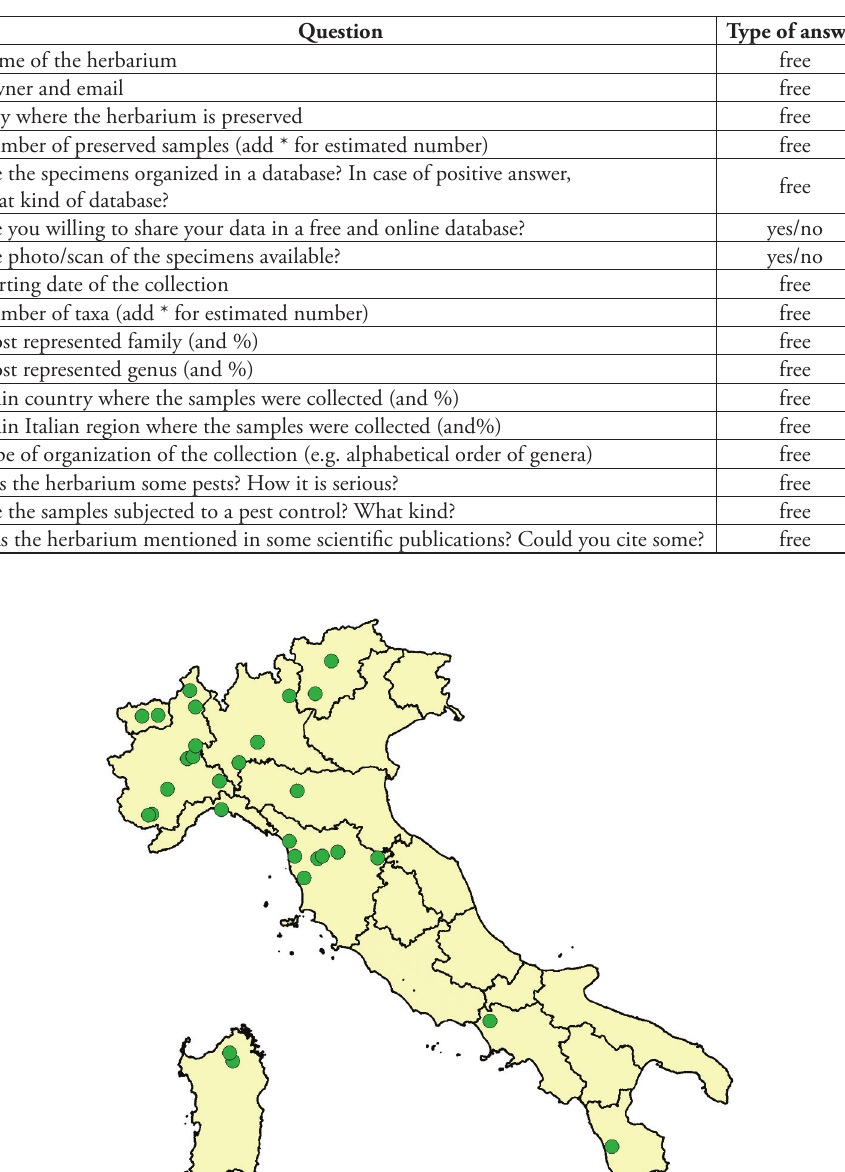
Table 1. Questions proposed in the online survey.